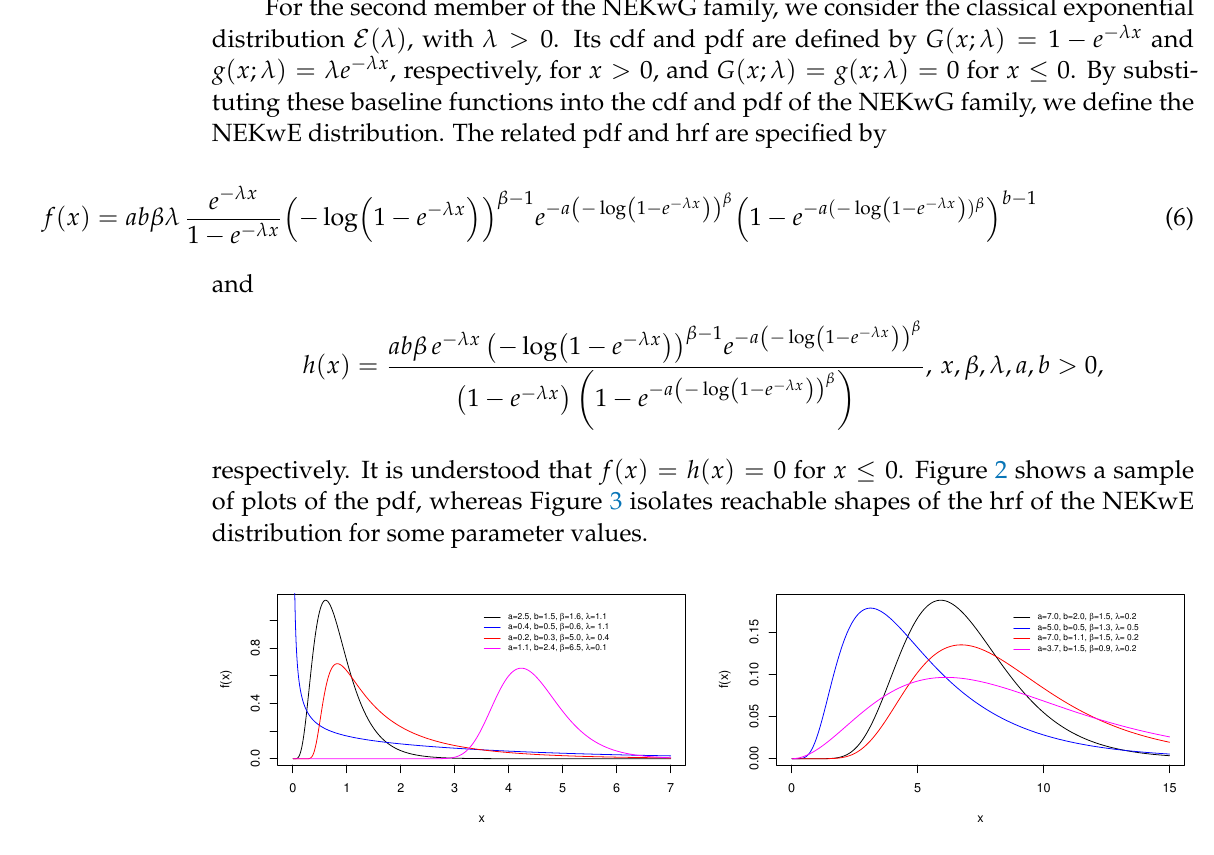
Figure 2. Sample of plots of the pdf of the NEKwE distribution: ( left ) decreasing and unimodal, right-skewed, and near-symmetrical shapes and ( right ) unimodal right shapes with various modes and kurtosis.